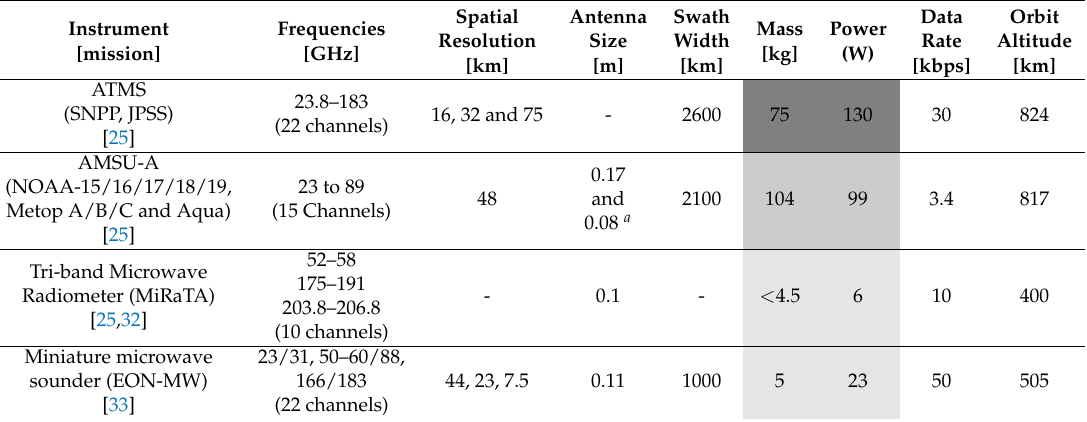
The background color in the table indicates the type of platform suitable for the instrument according to the power and mass requirements: Very light gray: Nano-platform; Light gray: Micro-platform; Gray: Mini-Platform; a This instrument has two antennas with different